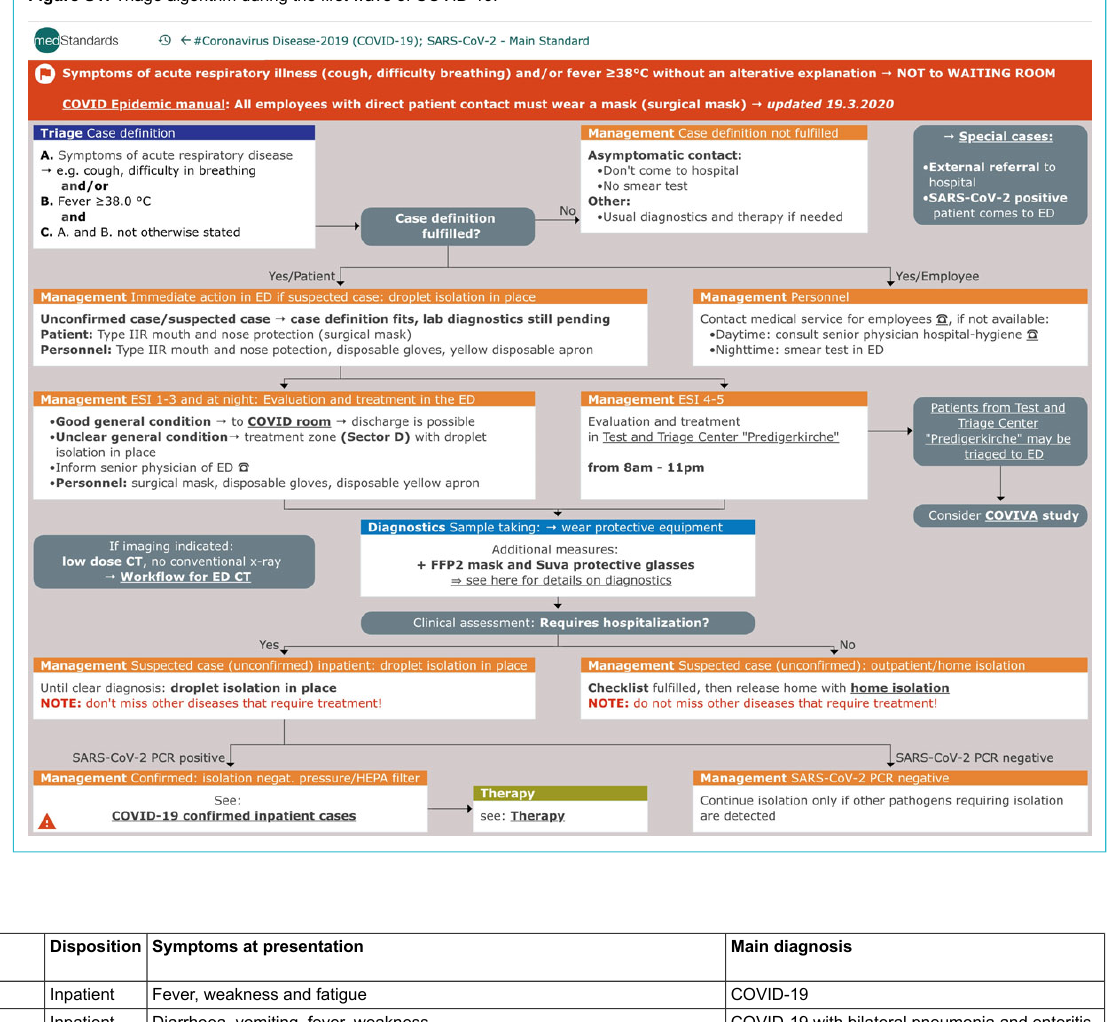
Figure S1: Triage algorithm during the first wave of COVID-19.